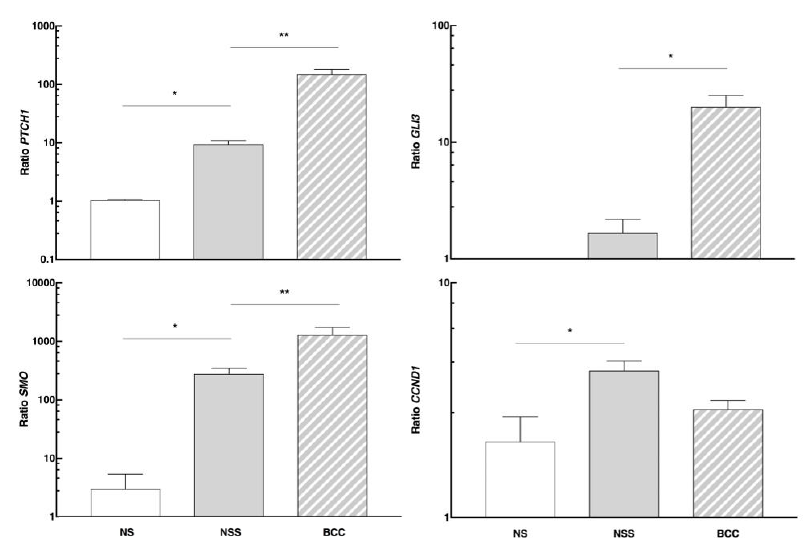
Figure 3. mRNA levels of PTCH1 , SMO , GLI3 , and CCND1 genes studied in normal skin (NS) of controls, as well as in the normal surrounding skin (NSS) and basal cell carcinomas (BCC) of NBCCS patients. * p < 0.05 and ** p < 0.03.